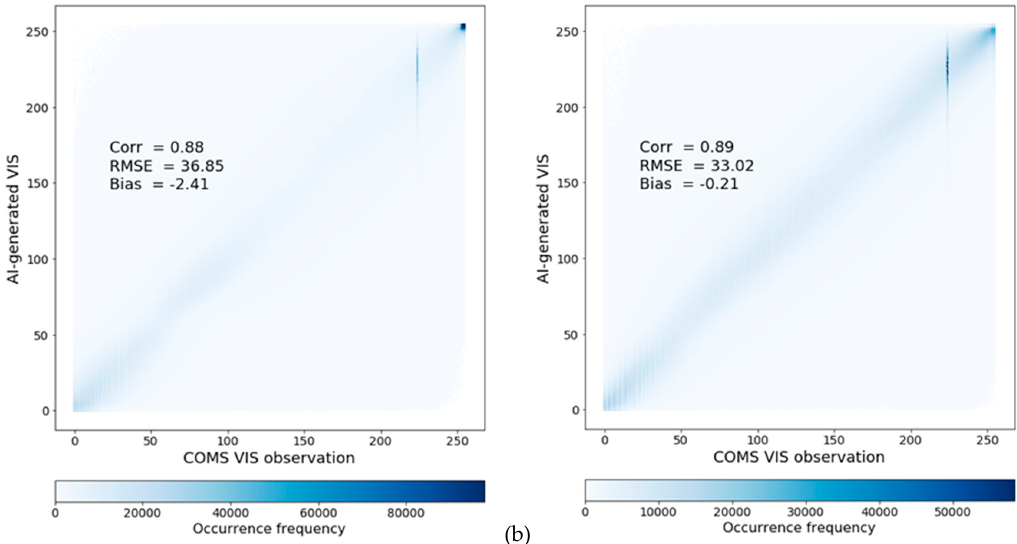
Figure 6. Scatterplots and statistical results of AI-generated reflectance during (a) summer (June 2018